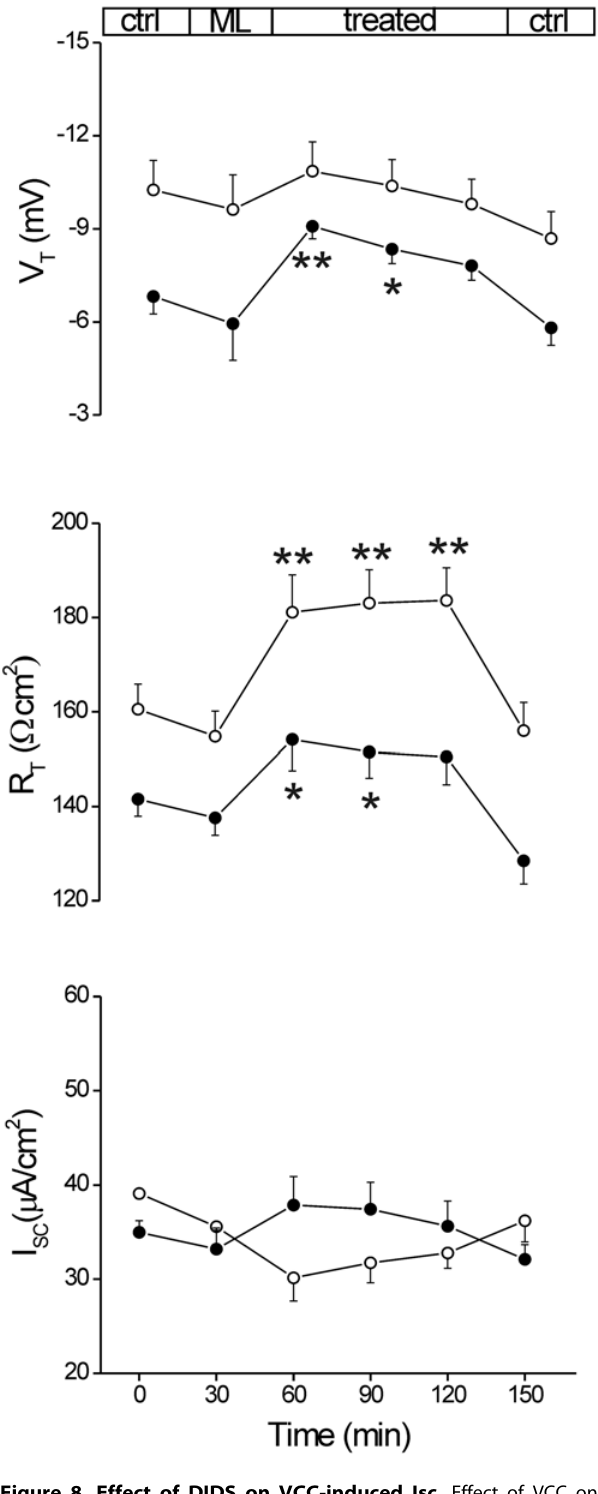
Figure 8. Effect of DIDS on VCC-induced Isc. Effect of VCC on human sigmoid colon Cl 2 conductance was tested by mucosal exposure to DIDS (1 mM) in the presence (n=7; m=4) or in the absence (n=7; m=5) of VCC 1 nM. Filled circles refer to toxin-exposed tissues while empty circles refer to non-treated tissues. Electrical parameters were measured in the basal state (Ctrl), during incubation with DIDS or DIDS plus VCC added to the mucosal side (Treated) and after removing the agonists (Ctrl). Significance was determined by Student’s t test for paired data of control (time=0) and treated; *, p , 0.05;**, p ,